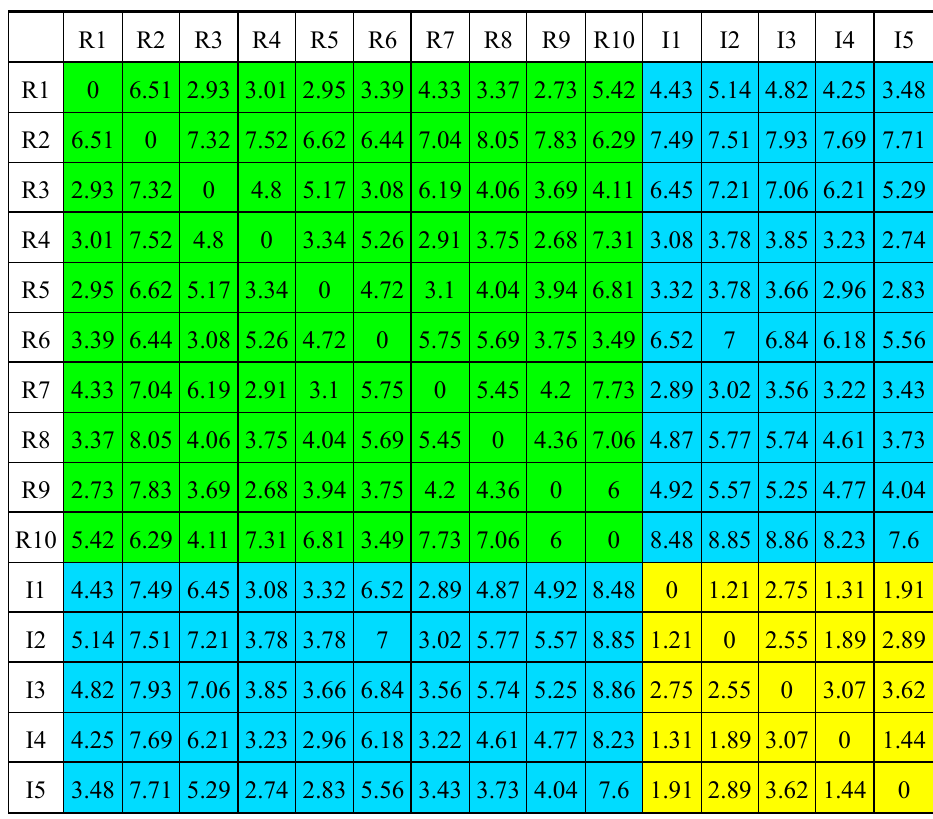
Table 5. Pairwise backbone RMSD of the ten structures modeled by ROBETTA and five structures modeled by